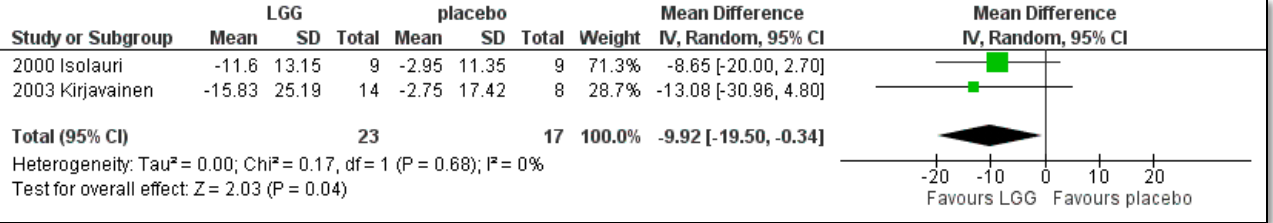
Figure 9. Subgroup meta-analyses of the effect of 3 months supplementation with Lacticaseibacillus rhamnosus GG (LGG) compared to placebo on the SCORAD index change in children with AD aged under 1 year at treatment time [41,42].